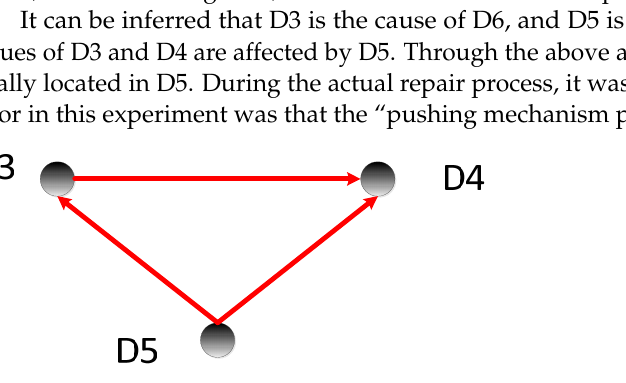
Figure 8. Cause-and-effect diagram